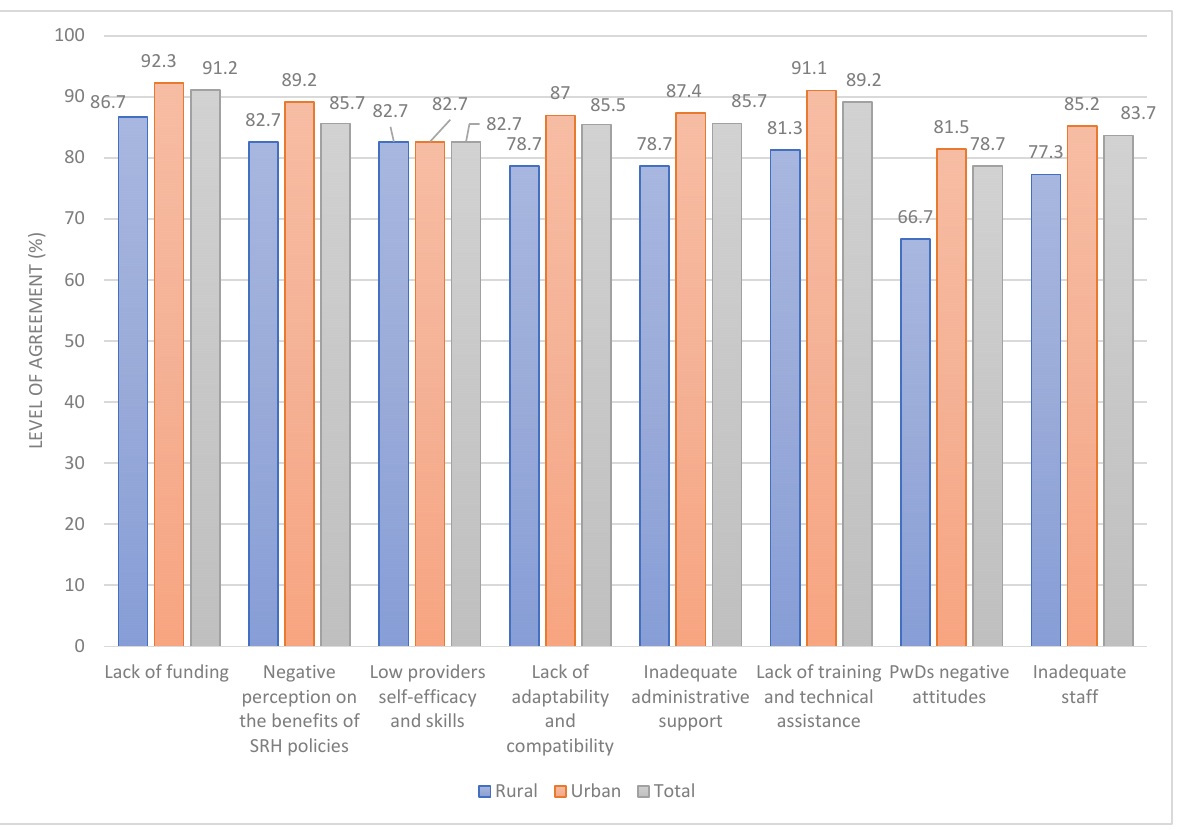
Figure 3. Factors influencing successful delivery of sexual and reproductive health services to per- sons with disabilities.